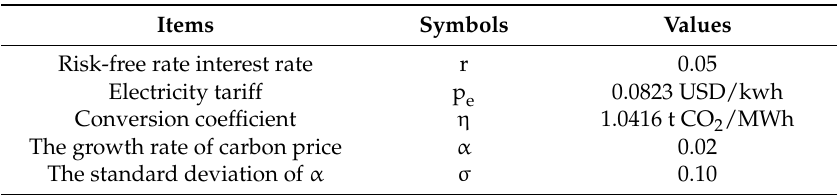
Table 2. Environmental